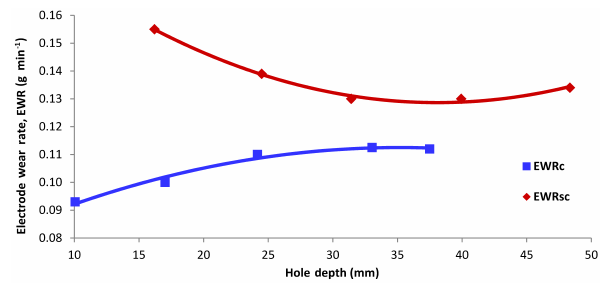
Figure 9. Results of EWR with respect to hole depth.